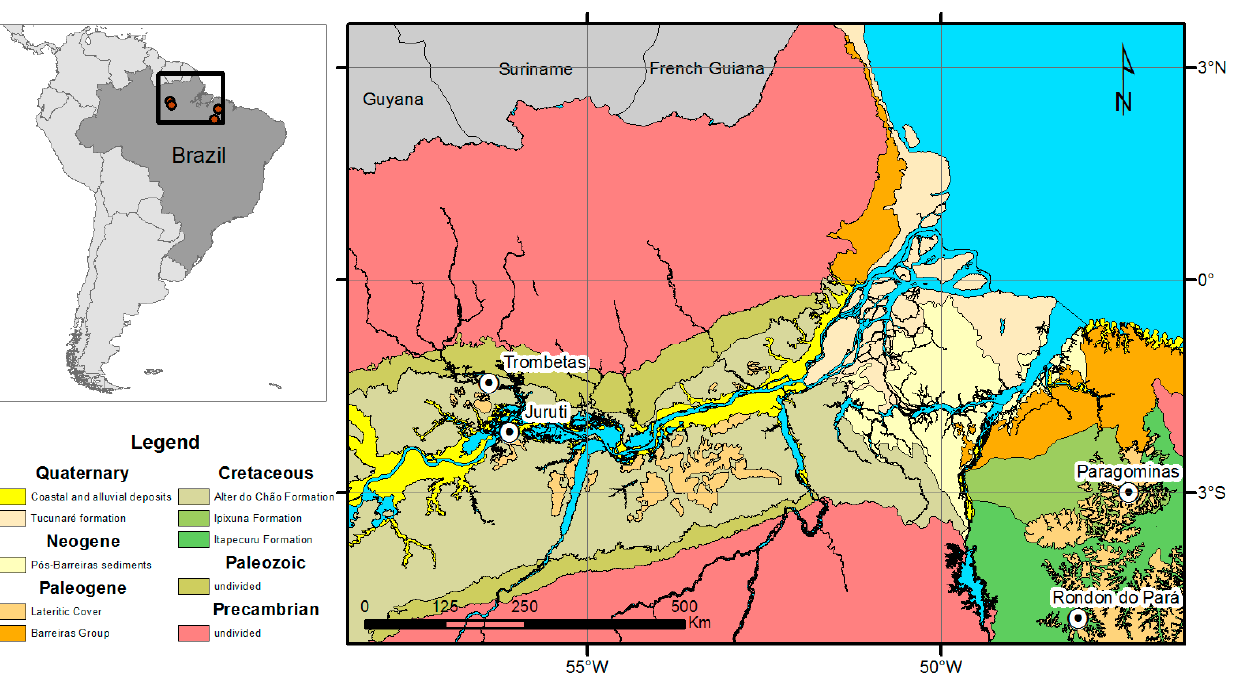
Figure 1. Geologic map with the location of the Rondon do Pará deposit along with other world-class Amazon bauxite deposits (after de Oliveira et al. [9]).